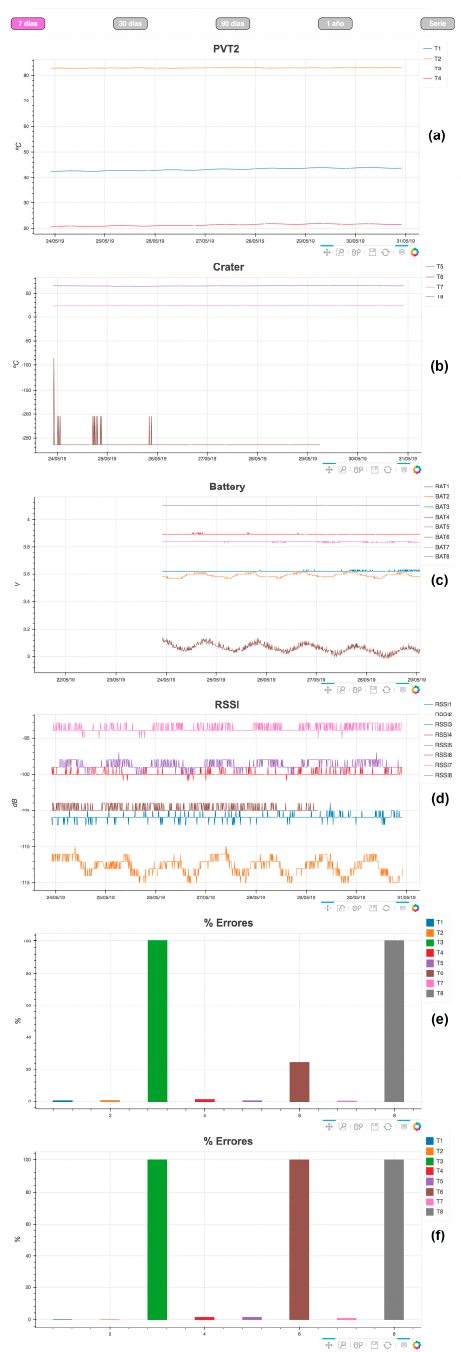
Figure 10. Webpage. ( a ) Temperature values measured by thermometers in area A; ( b ) Temperature values measured by thermometers in area B; ( c ) Battery level of each thermometer; ( d ) RSSI level of each thermometer measured in the repeater; ( e ) Percentage of error of each thermometer in the last 24 h; ( f ) Percentage error for the selected time